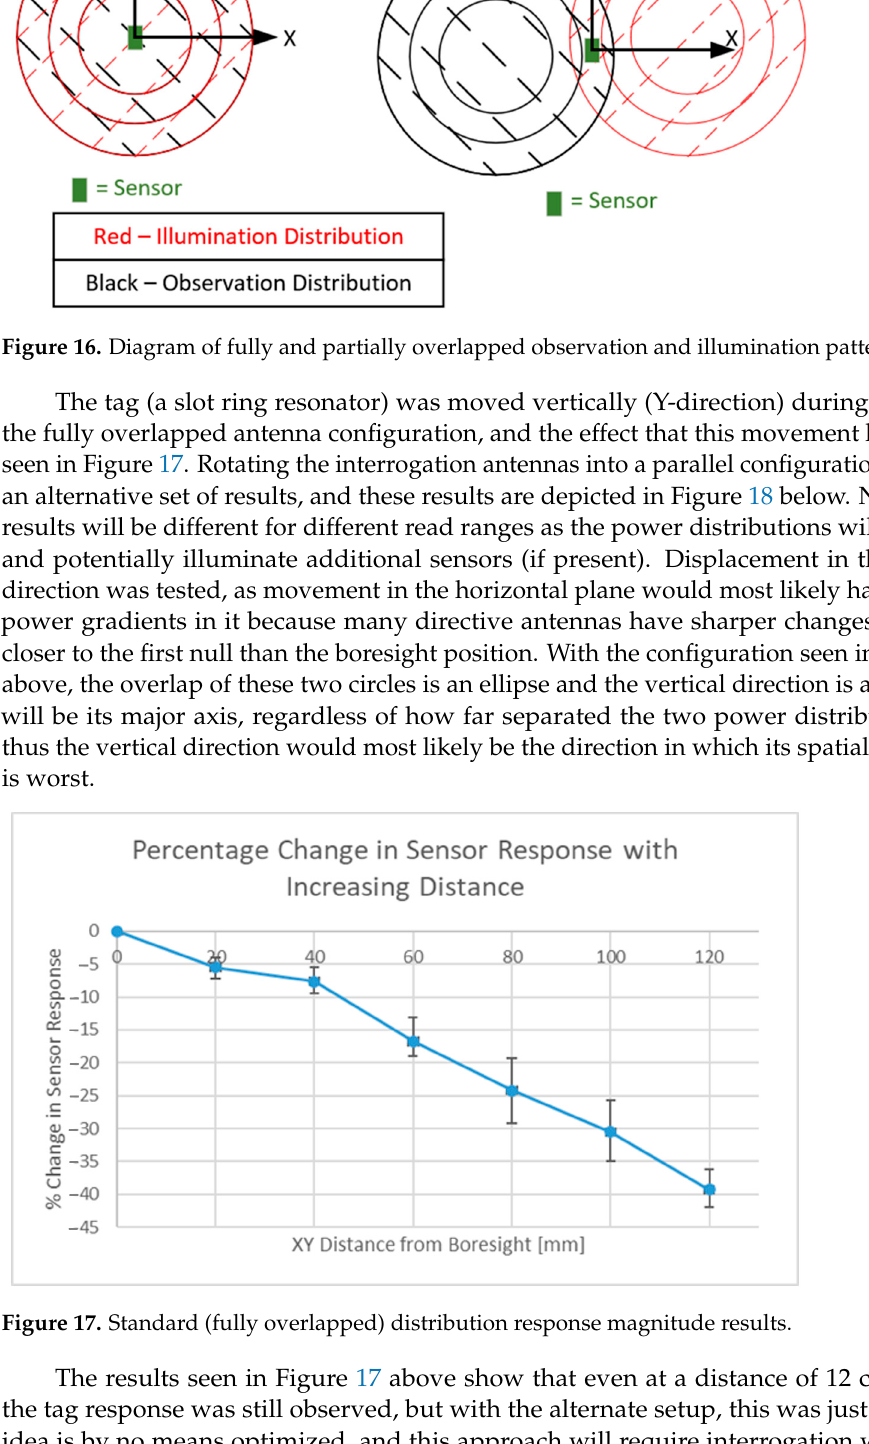
Figure 18. Response magnitude results from partially overlapped distribution. The results seen in Figure 17 above show that even at a distance of 12 cm, 60% of the tag response was still observed, but with the alternate setup, this was just 25%. This idea is by no means optimized, and this approach will require interrogation with beam ‐ steer ‐ ing capabilities to target individual sensors and to emphasize the effect (target a smaller overlap), which may be particularly useful when the read range increases. With that being said, another benefit observed during testing was that the background measurement had a lower magnitude, as the scattering response under a single ray assumption was caused only by the region that was both illuminated and observed. 4. Conclusions Overall, this paper presented a number of interesting results, including the design and testing of novel strain and temperature sensors and an initial attempt at defining the interrogation system requirements needed to make the resulting performance of the over ‐ all sensor technology suitable for aerospace applications. Along with sensor development and spectrum requirement analysis, this work also presented a thorough model of the interrogation system and subsequently discussed some of the usually overlooked aspects of its design and their importance to aerospace SHM and indeed SHM in general. A con ‐ servative viewpoint was taken throughout this work and thus some alternative ap ‐ proaches to combatting the challenges posed by the multi ‐ sensor setting were also